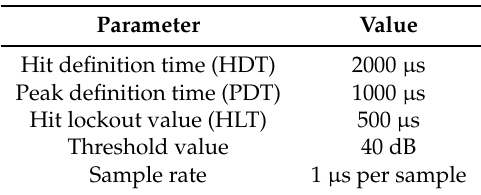
Table 1. AE parameters.